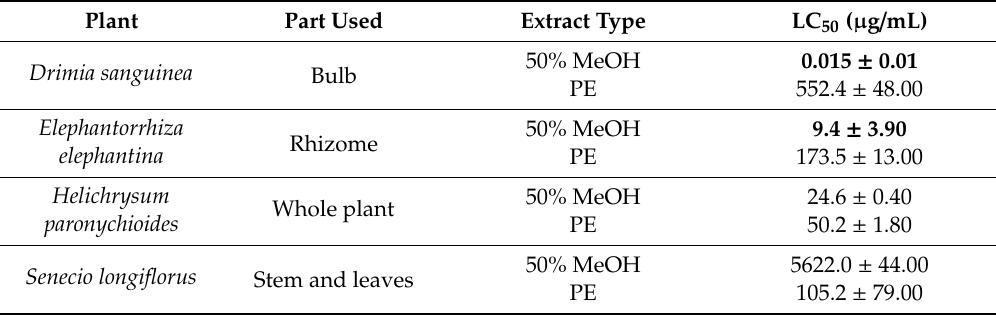
Table3. Cytotoxicity(LC 50 )ofextractsfromfourplantsusedbyBatswanatraditionalhealthpractitioners to treat skin diseases. The LC 50 ( µ g / mL) values represent the mean ± standard error ( n = 3). The values in bold represent extracts considered toxic; LC 50 < 20 µ g / mL (the established cytotoxicity safety standard) and that of the positive control (Doxorubicin: 10.2 µ g / mL). MeOH = methanol, PE = petroleum